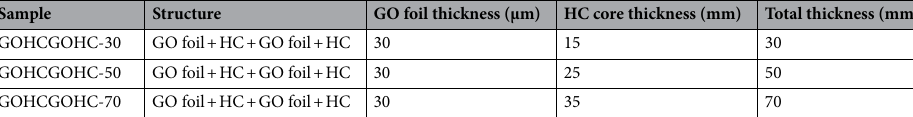
Table 1. Design parameters of proposed GOHCGOHC with different HC